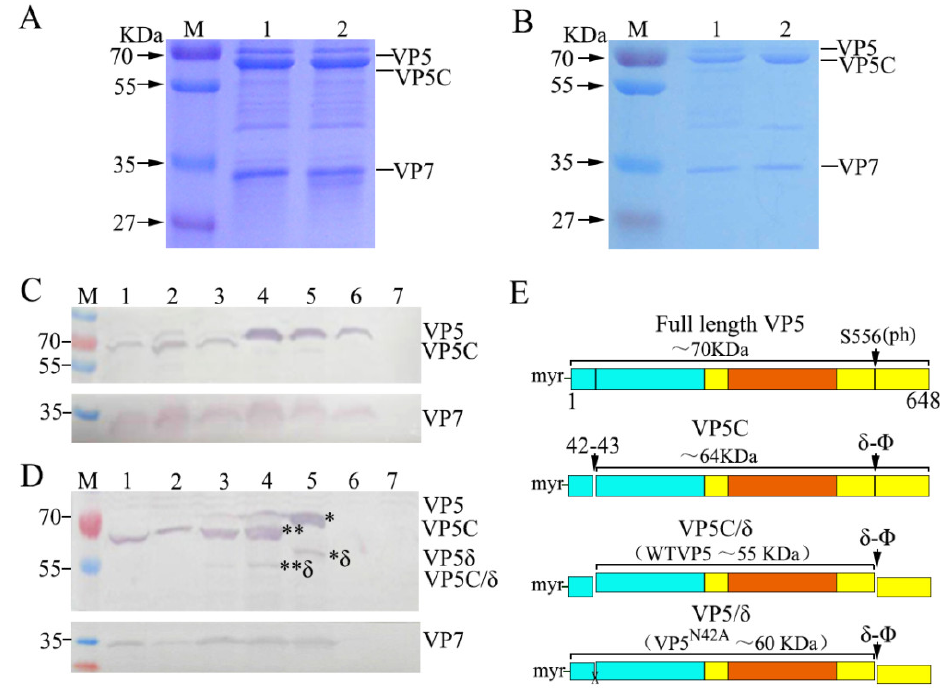
Figure 5. Identification of VP5 and VP5C conformations in GCRV particles and infected cells. ( A,B ) VP5 conformations were analyzed using SDS-PAGE, followed by Coomassie staining from purified